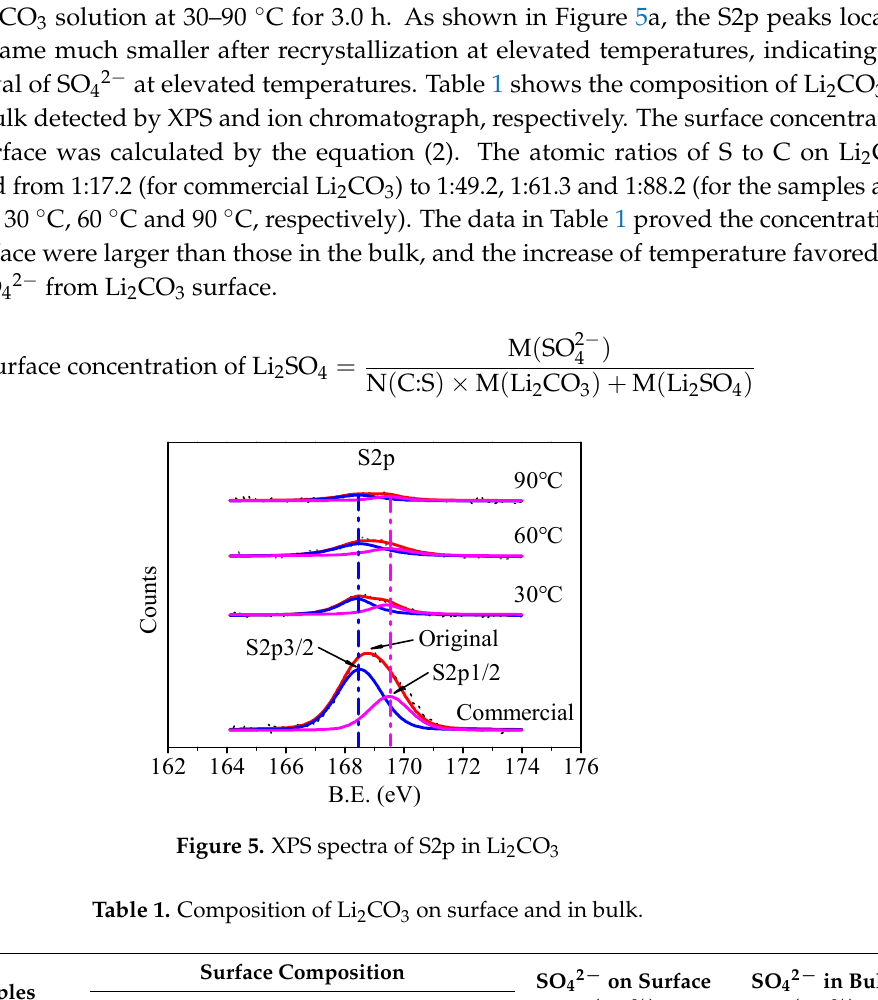
Figure 4. FT-IR spectra of Li 2 CO 3 samples before and after recrystallization in Na 2 CO 3 solution.